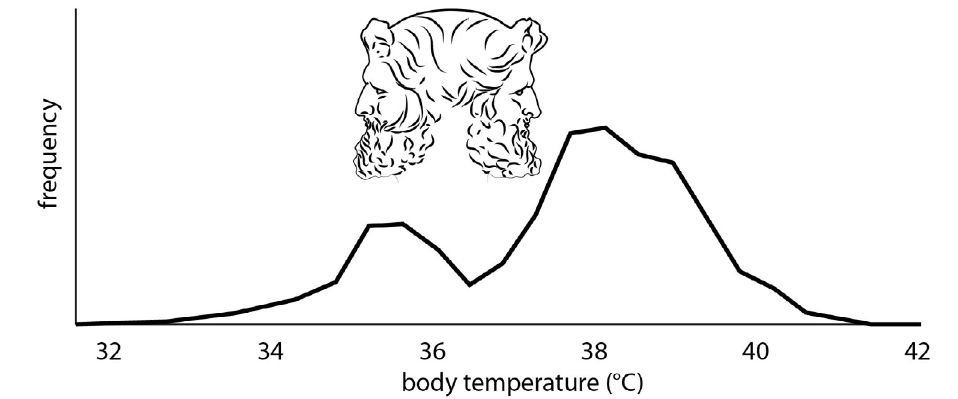
Figure 1. Frequency distribution of body temperature ( o C) in sepsis patients Note. Adapted from “Fever and hypothermia represent two populations of sepsis patients and are associated with outside temperature,” by Thomas-Rüddel DO, Hoffmann P, Schwarzkopf D, Scheer C, Bach F, Komann M, et al. Crit Care.